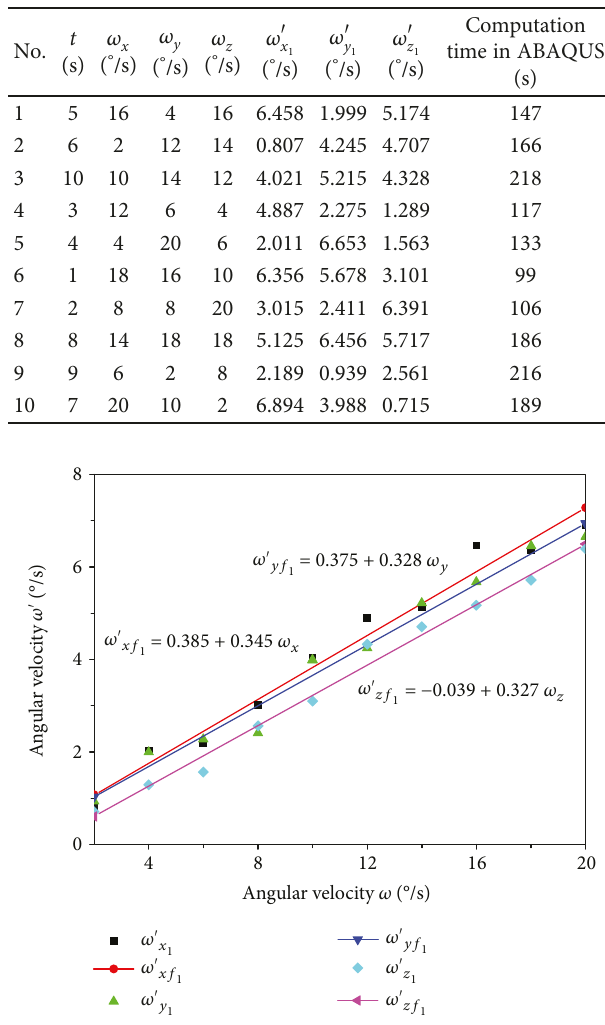
Table 8: Simulation results of empty storage tank.